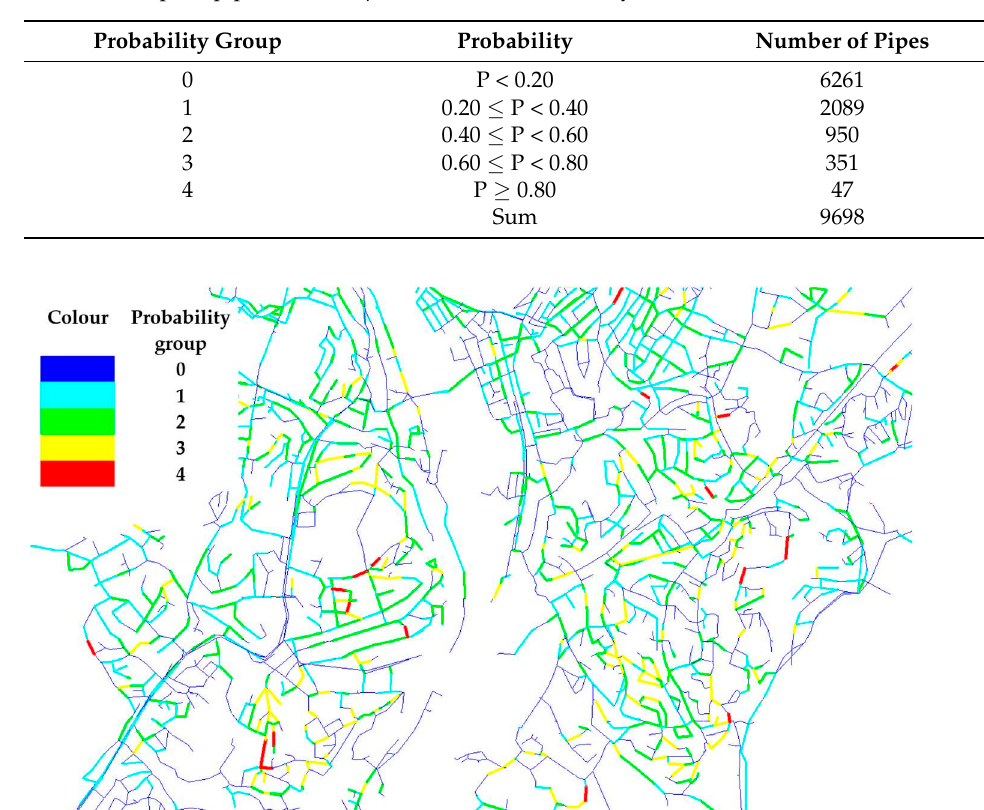
Figure 5. An excerpt of the WDN showing classification of pipes according to p values from RF-BA